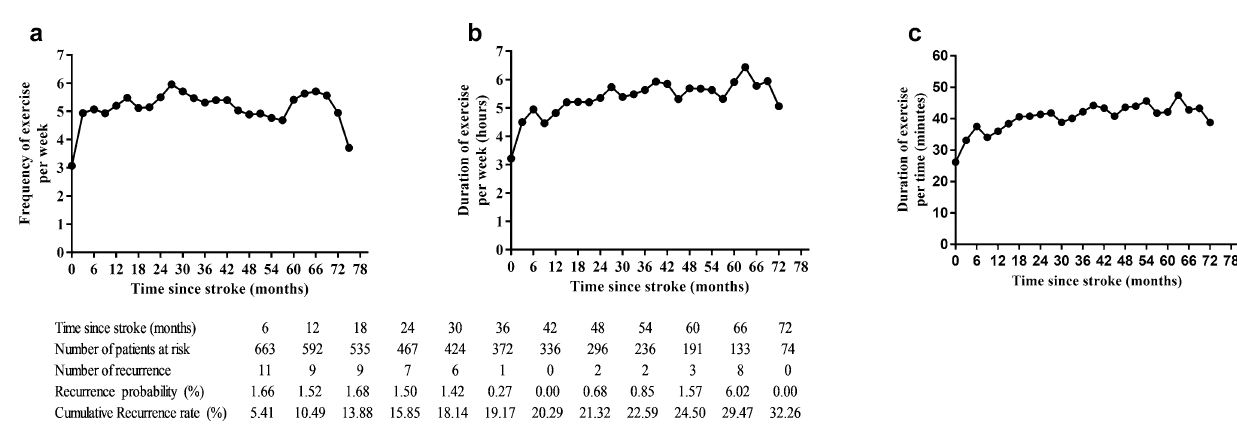
Figure 2. Changes in physical exercise before and after ischaemic